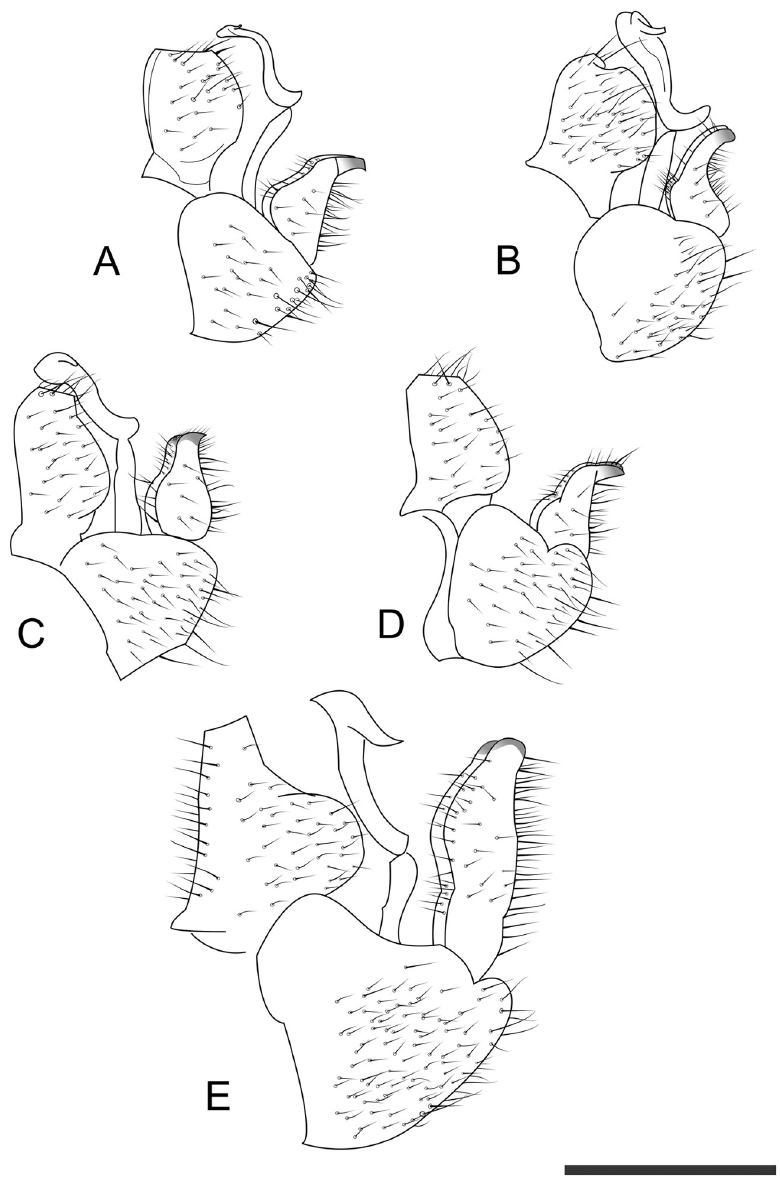
Fig 6. Lateral view of male terminalia of Trioza melaleucae ( A ), T . curta ( B ), T . adventicia ( C ), T . eugeniae ( D ) and T . erytreae ( E ). Scale bar is 0.2